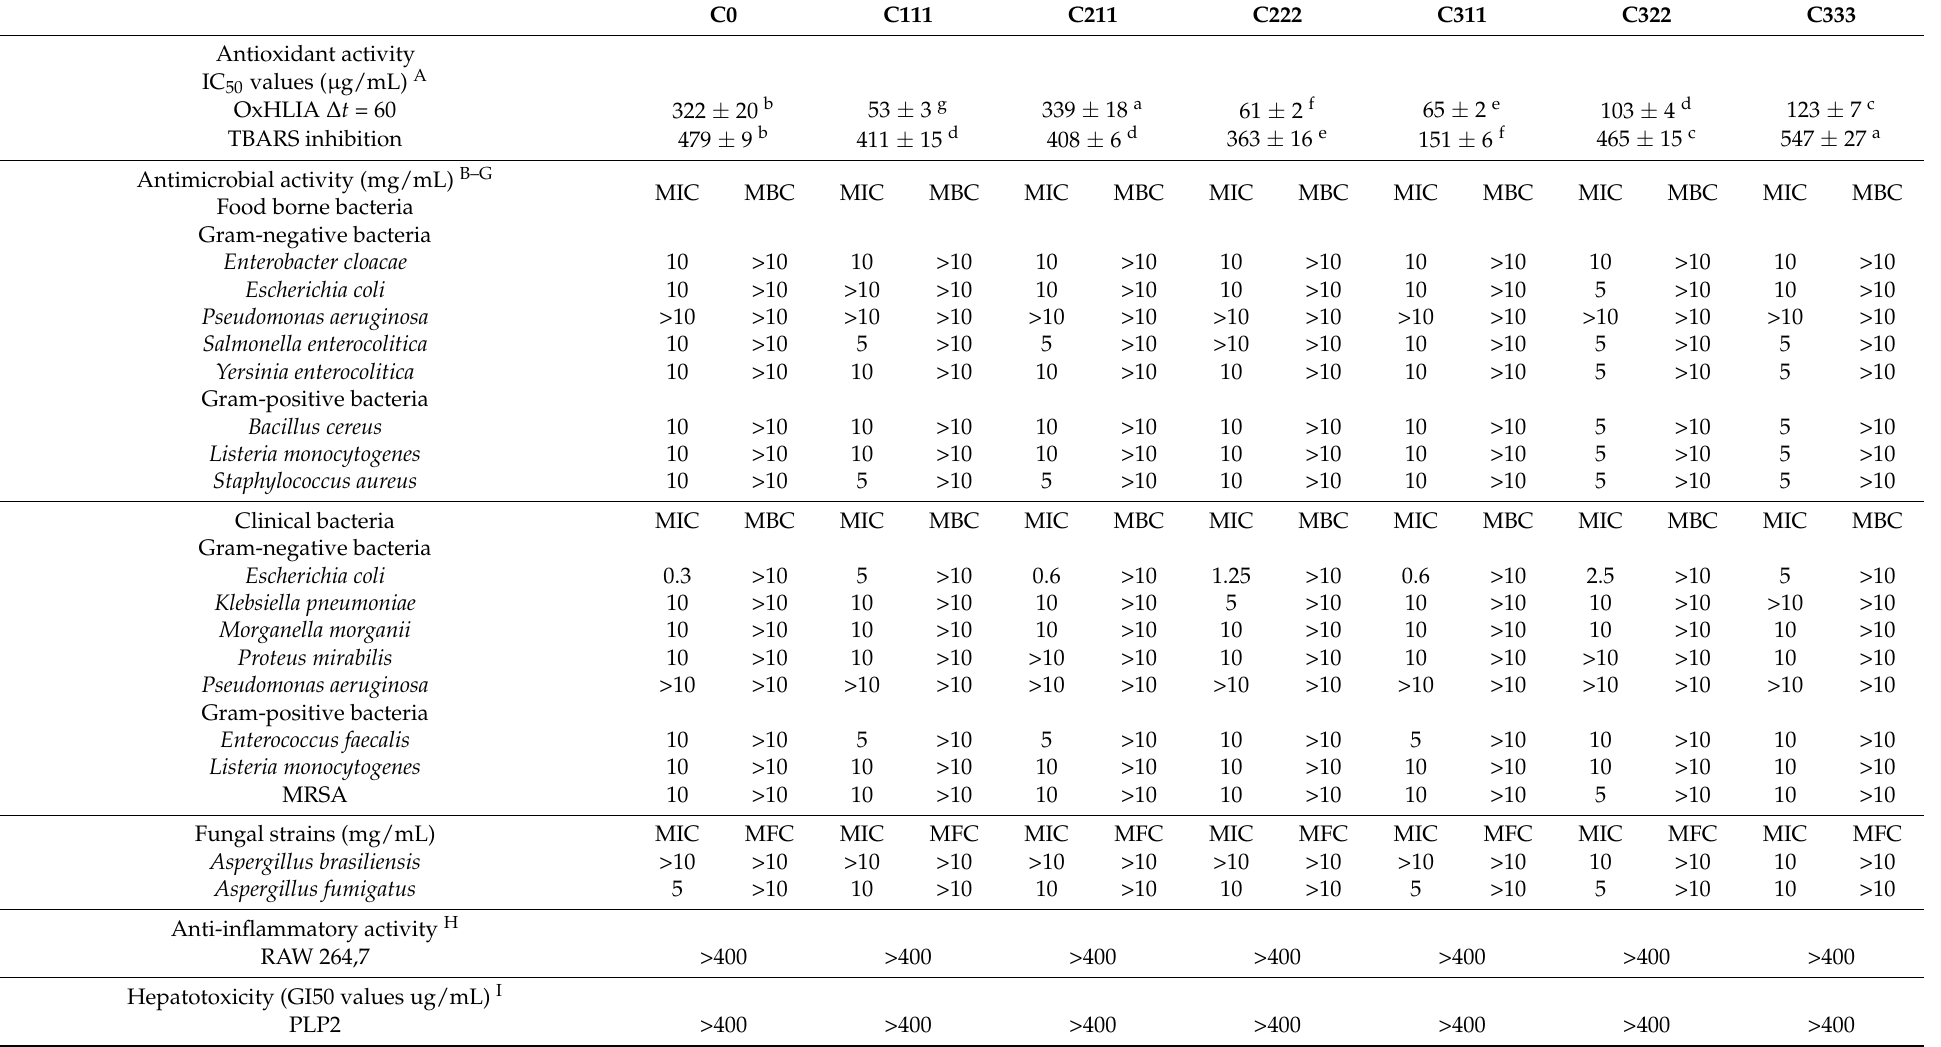
Table 7. Antioxidant, antimicrobial, anti-inflammatory, hepatotoxic, and cytotoxic activities of the hydroethanolic extract of C. spinosum (mean ±